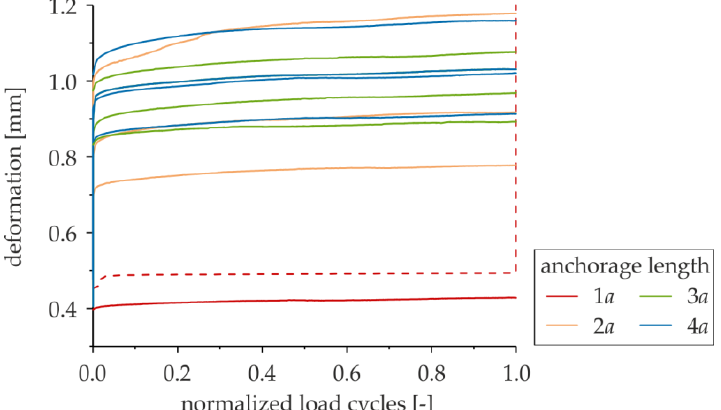
Figure 8. Comparison of normalized cyclic creep curves depending on the amplitude (here: anchorage length = 3 a ).